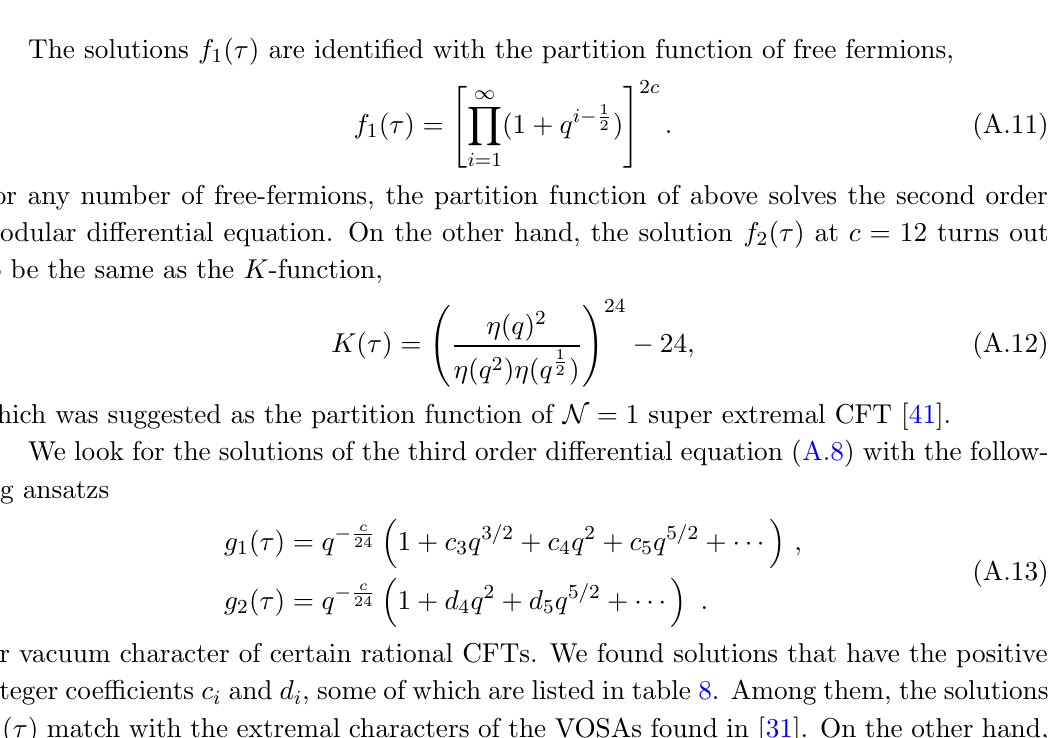
Table 8 . The list of solutions for the third order modular di(cid:11)erential